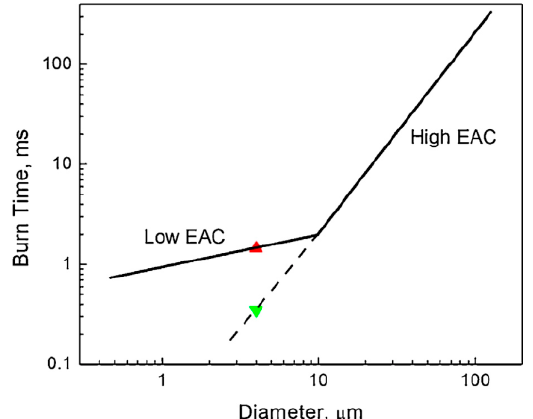
Figure 21. Burning time vs. Al particle diameter dependency. Reproduced from [69], with permission from Elsevier, 2020.